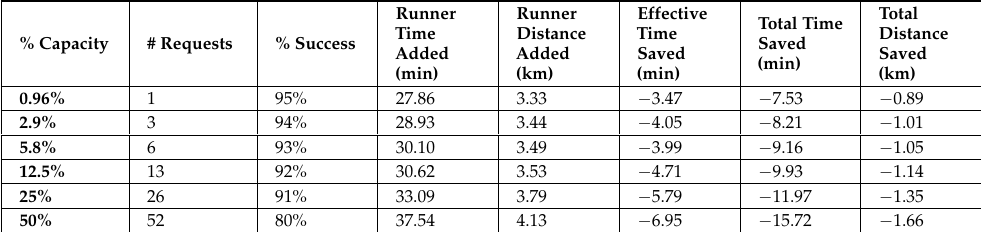
Table 3. Results from UC Irvine campus feasibility